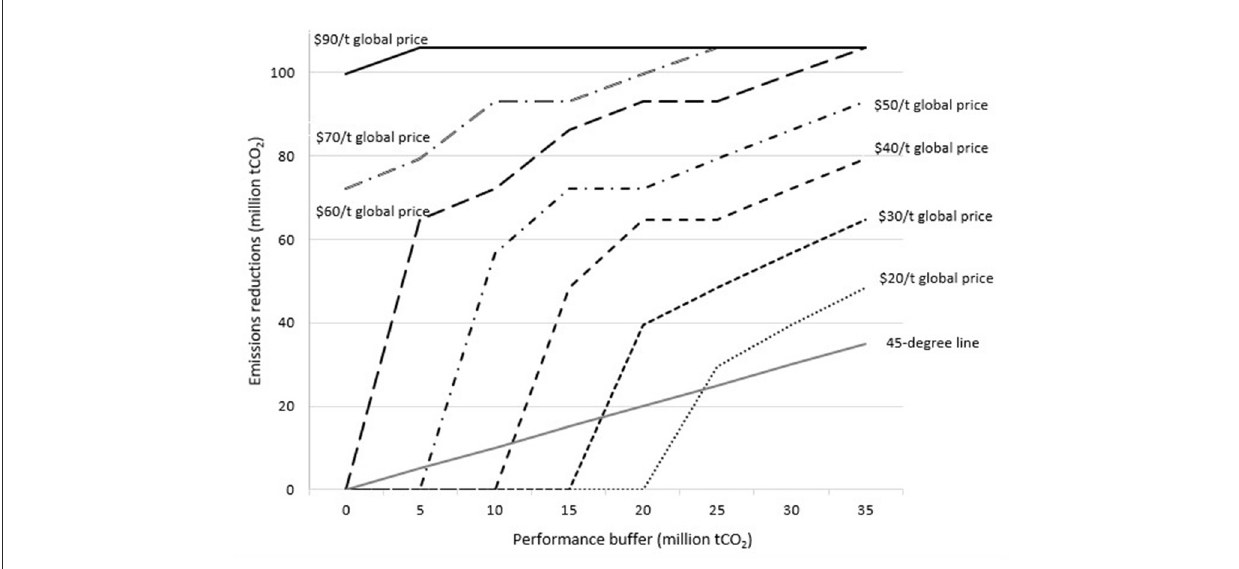
FIGURE8 Performance buffer and median supply of emissions reductions at or above break-even, by different global prices. Note: Assumed minimum abatement requirement ( Q ) equals 35 million tCO 2 such that international payments are only made for abatement exceeding that